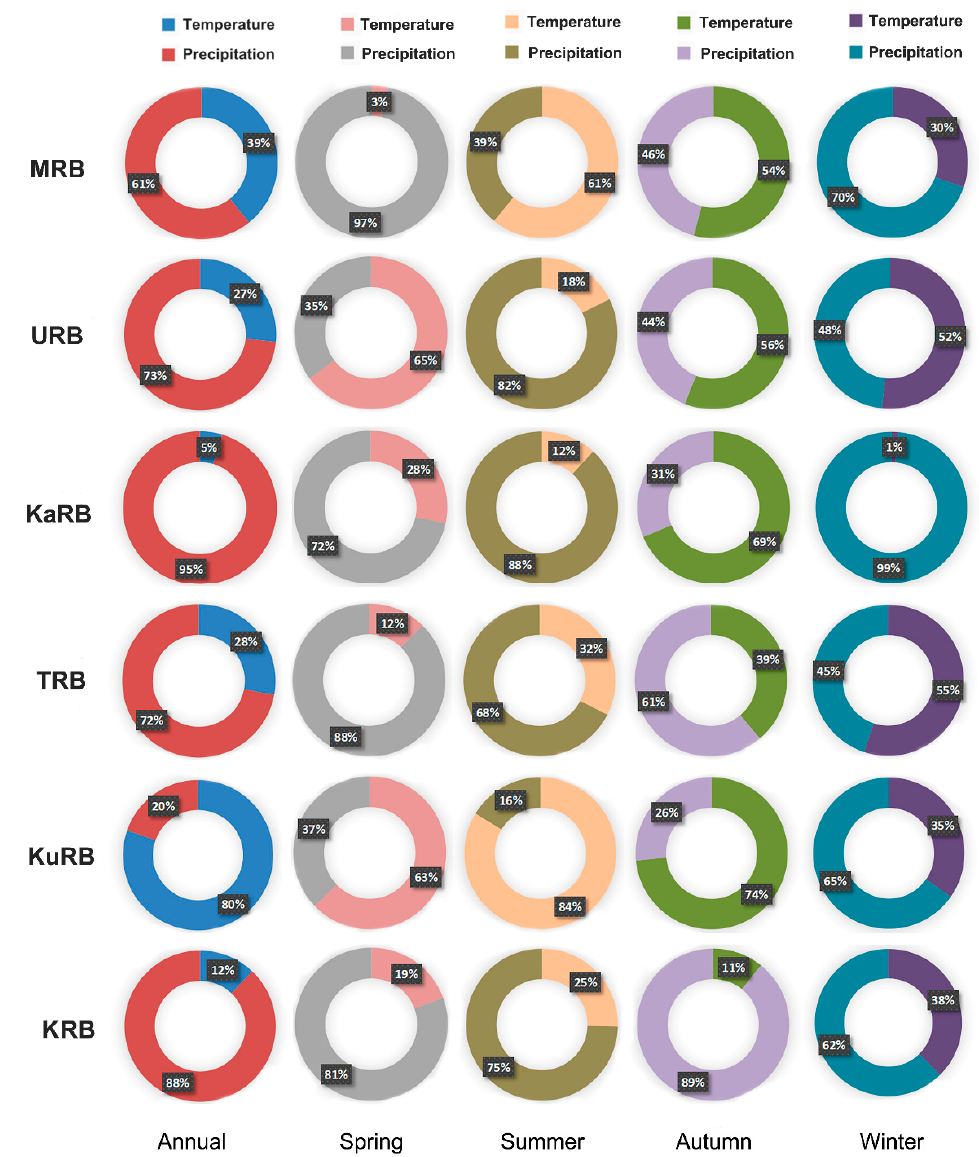
Figure 4. Contributions of precipitation and temperature change to runoff.